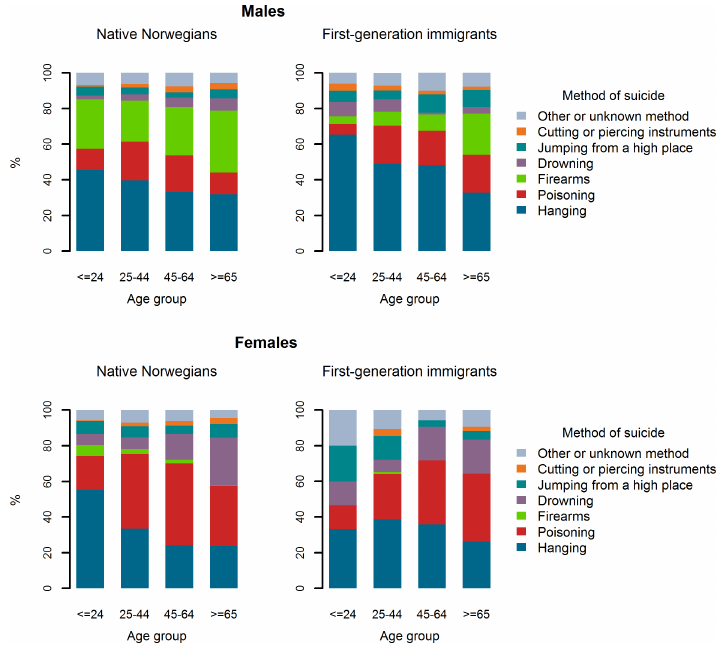
Fig 1. Distribution of suicide cases by specific methods in various age groups of native Norwegians and first- generation immigrants, 1992–2012.